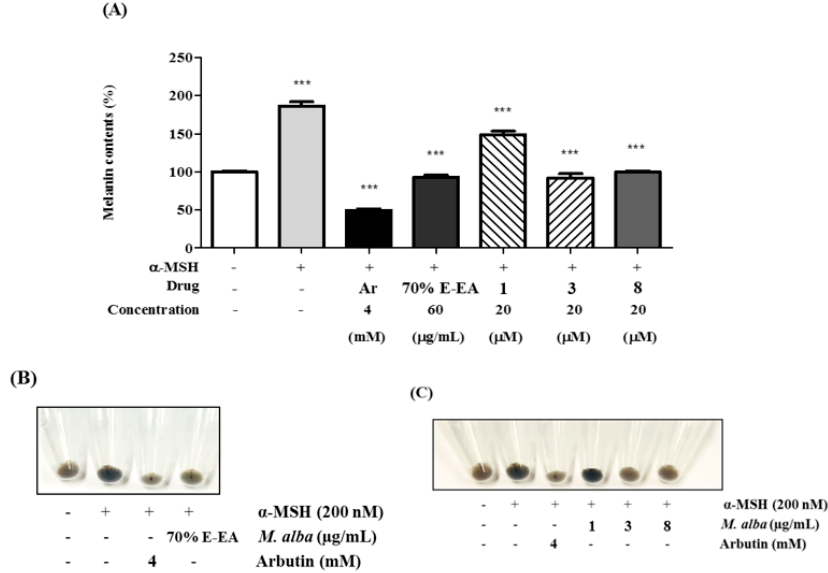
Figure 3. Effects on melanogenesis in murine B16-F10 cells; B16-F10 cells were pretreated with test samples for 2 h and then incubated with alpha-melanocyte-stimulating-hormone ( α -MSH) (200 nM) for 72 h. The cell pellets were dissolved in 1N NaOH with 10% DMSO. The cell lysates were transferred to 96-well plates and the absorbances at 405 nm were detected using an ELISA microplate reader. ( A ) 70% E-EA, 1 , 3 , and 8 decreased the α -MSH-induced production of melanin. *** p < 0.001 compared with the α -MSH-treated group; ( B , C ) indicate the colors of the pellets from α -MSH-induced B16-F10 melanoma cells.